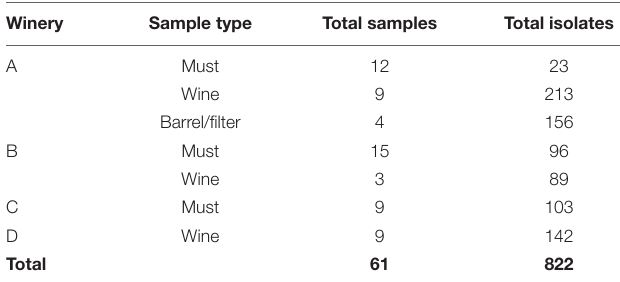
TABLE 2 | Primers used for the identification of lactic acid bacteria (LAB) by multiplex PCR. Primer Sequence